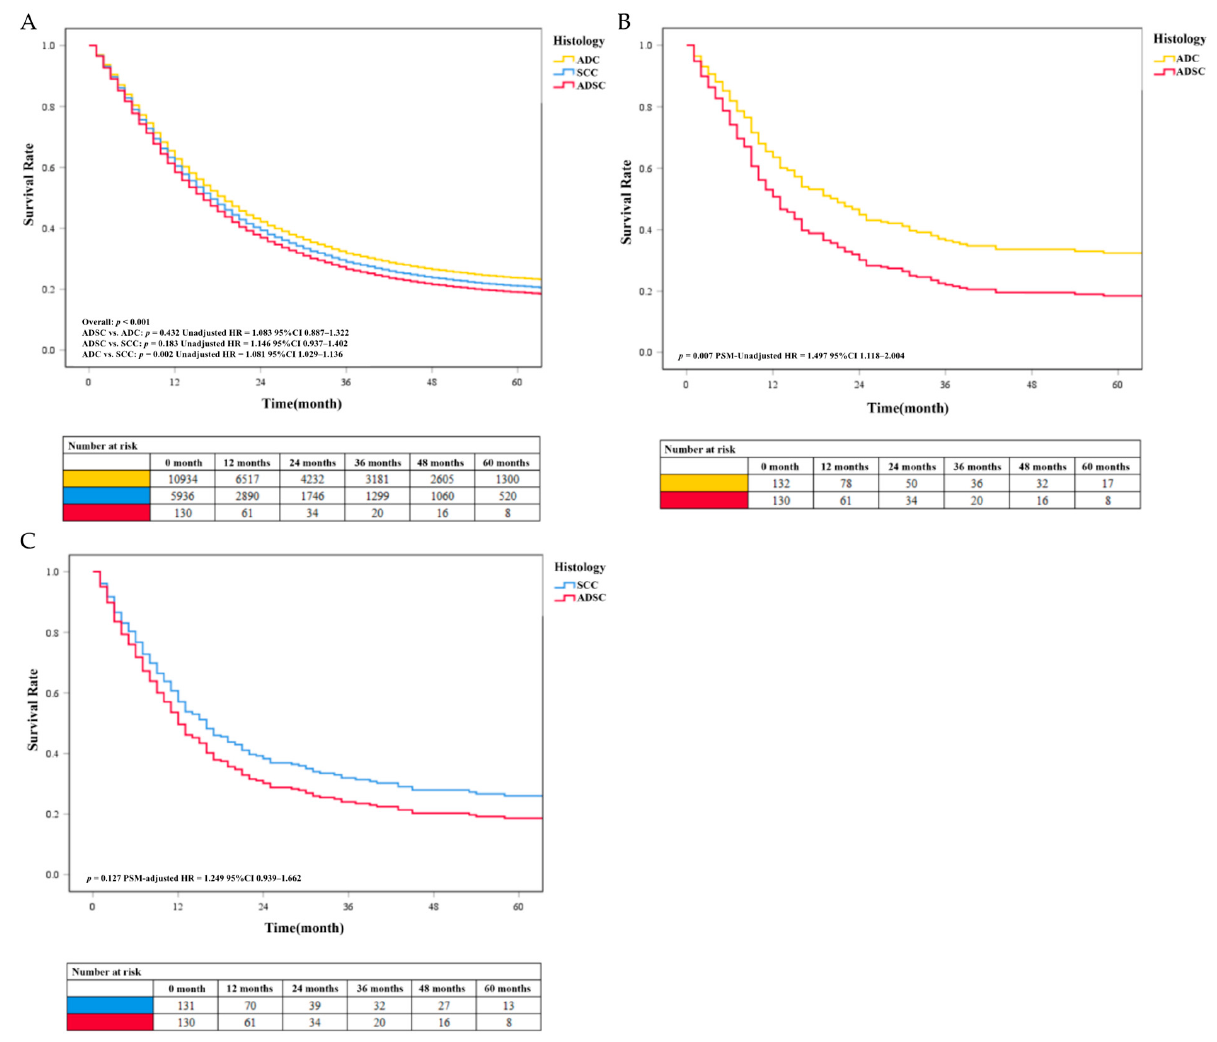
Figure 4. ( A ) The unadjusted survival curves of different histology classifications before PSM. The COX survival curves of EC with different histology classifications after PSM. ( B ) Survival comparison between the ADC and ADSC groups. ( C ) Survival comparison between the SCC and ADSC groups.